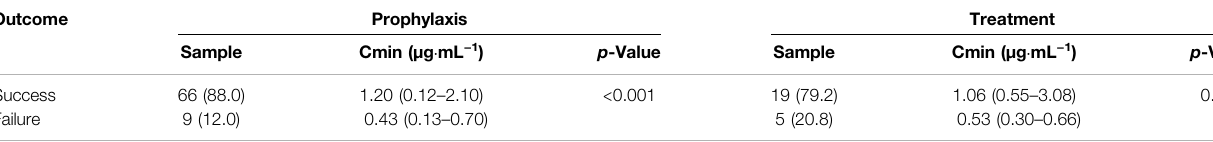
TABLE 3 | Relationship between outcomes and PCZ Cmin. Outcome